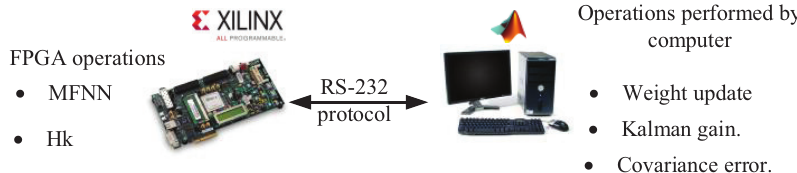
Figure 11. HIL performed by FPGA and